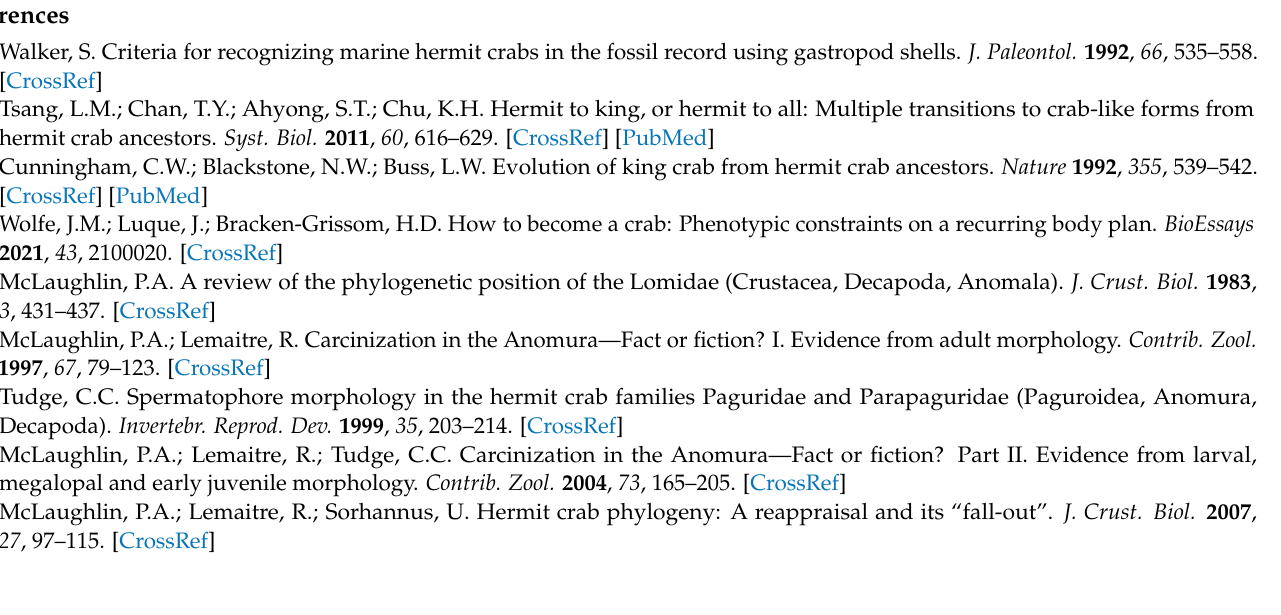
Table S4: Species information and accession numbers for the COI sequences downloaded from NCBI for assessment of Pagurus species diversity. Table S4-1: Species information and accession numbers for the selected COI sequences used for assessment of Pagurus species diversity. Table S5: Species information and accession numbers for the selected 18S sequences used for assessment of Pagurus species diversity. Table S6: Species information and accession numbers for the selected 28S sequences used for assessment of Pagurus species diversity. Table S7: Species information and accession numbers for the selected H3 sequences used for assessment of Pagurus species diversity. Table S8: Species information and accession numbers for the concatenated mitochondrial genome sequences used for assessment of Pagurus species diversity. Table S9: Species of the genus Pagurus along the major geographical localities. Table S10: Pairwise genetic distance Kimura’s two-parameter model (K2P) values (per site) among Pagurus species based on complete mt genome. Table S11: Pairwise genetic distance Kimura’s two-parameter model (K2P) values (per site) among Pagurus species based on the 16S gene. Table S12: Pairwise genetic distance Kimura’s two-parameter model (K2P) values (per site) among Pagurus species based on the third codon of the COI gene. Table S13: Pairwise genetic distance Kimura’s two-parameter model (K2P) values (per site) among Pagurus species based on the 16S + COI